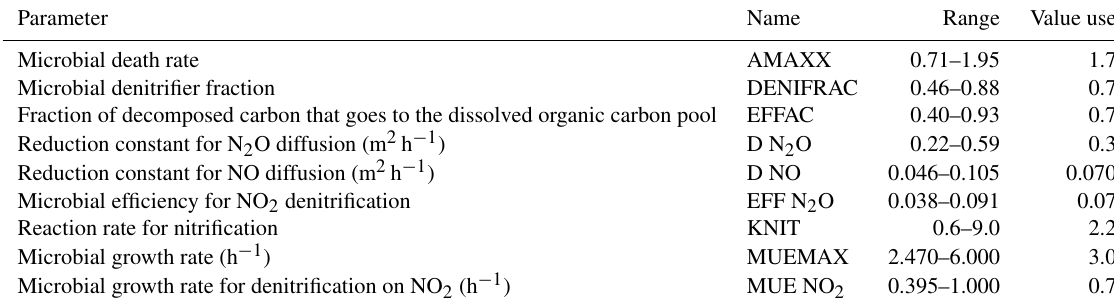
Table 1. Most critical soil biogeochemistry parameters of the Landscape-DNDC